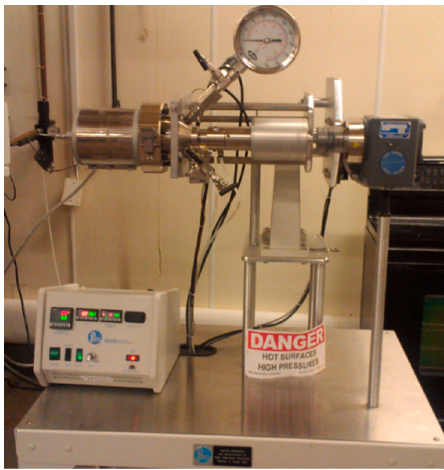
Figure 1. Stirred Parr reactor operating in horizontal positon.